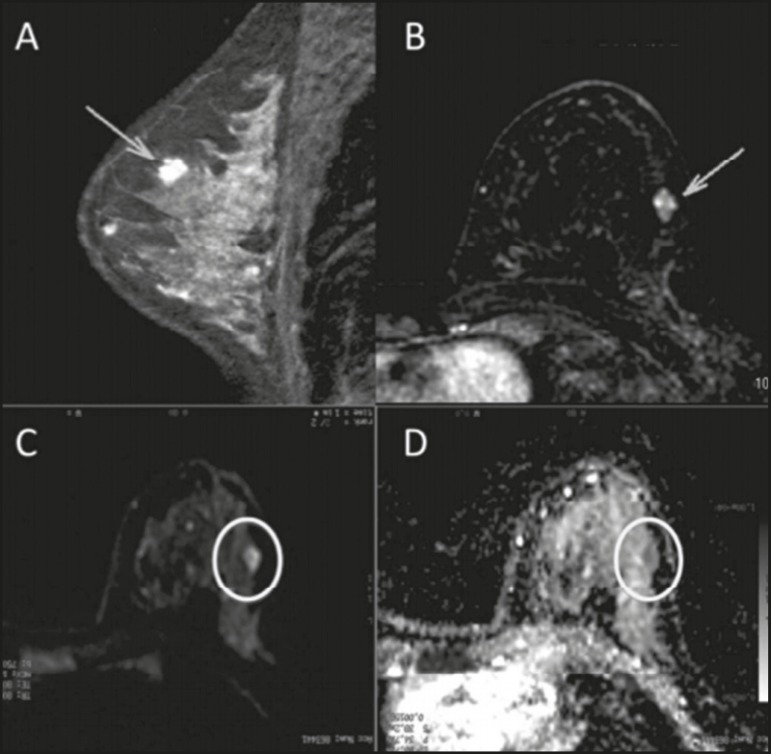
A 35-year-old female with invasive carcinoma in the right breast and
presenting with a nodule in the left breast on MRI. Contrast-enhanced
T1-weighted images, in the sagittal plane (A) and with subtraction in
the axial plane (B), showing a circumscribed nodule with heterogeneous
enhancement, high signal intensity in the DWI sequence (C), low signal
intensity on the ADC map (D), and an ADC value of 1.32 ×
10−3 mm2/s. The histological findings were
consistent with a diagnosis of fibroadenoma.